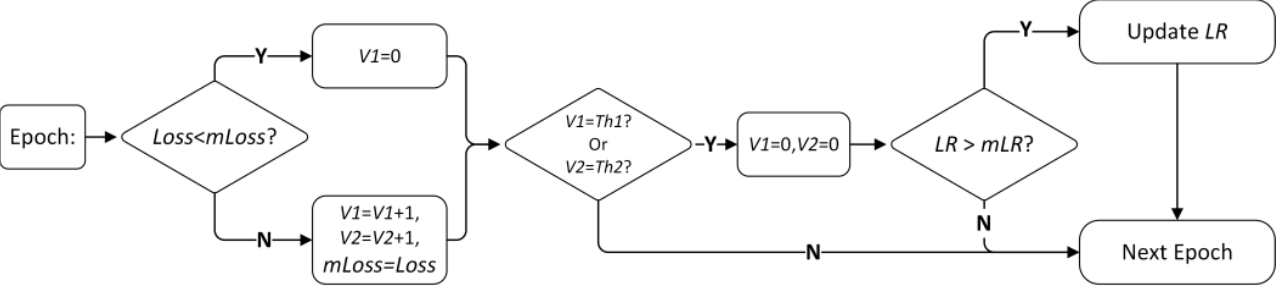
Figure 5. Method of optimizing the learning rate: V1 and V2 represent the two variables, Th1 and Th2 represent the thresholds, LR represents the learning rate and mLoss and mLR represent the minimum loss and minimum learning rate, respectively.